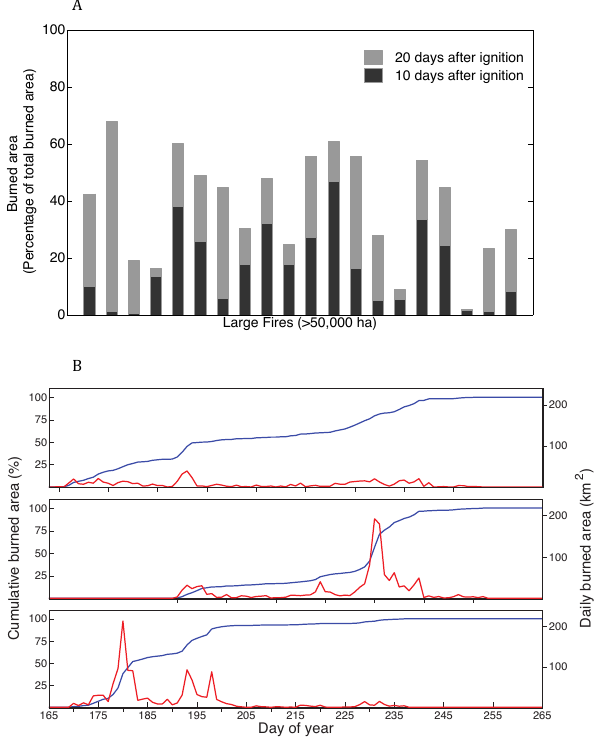
Figure 12. (A) Percentage of total burned area within 10 and 20 days after fire ignition for fires larger than 50000ha during the pe- riod 2002–2011. (B) Time series of daily (red line) and cumulative burned area (blue line) for three large fires in 2004. The fire in the lower middle panel had burned less than 35% of its final burned area within the first 40 days after its ignition, which made it a suit- able candidate for fire